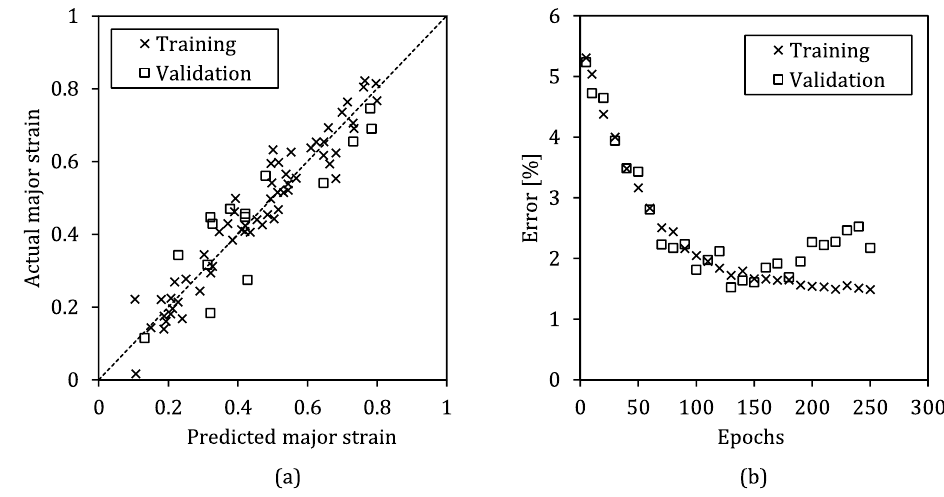
Figure 9. ( a ) correlation between predicted and actual values after training process, ( b ) Error between predicted and actual values of major engineering strain on FLC for both training and validation